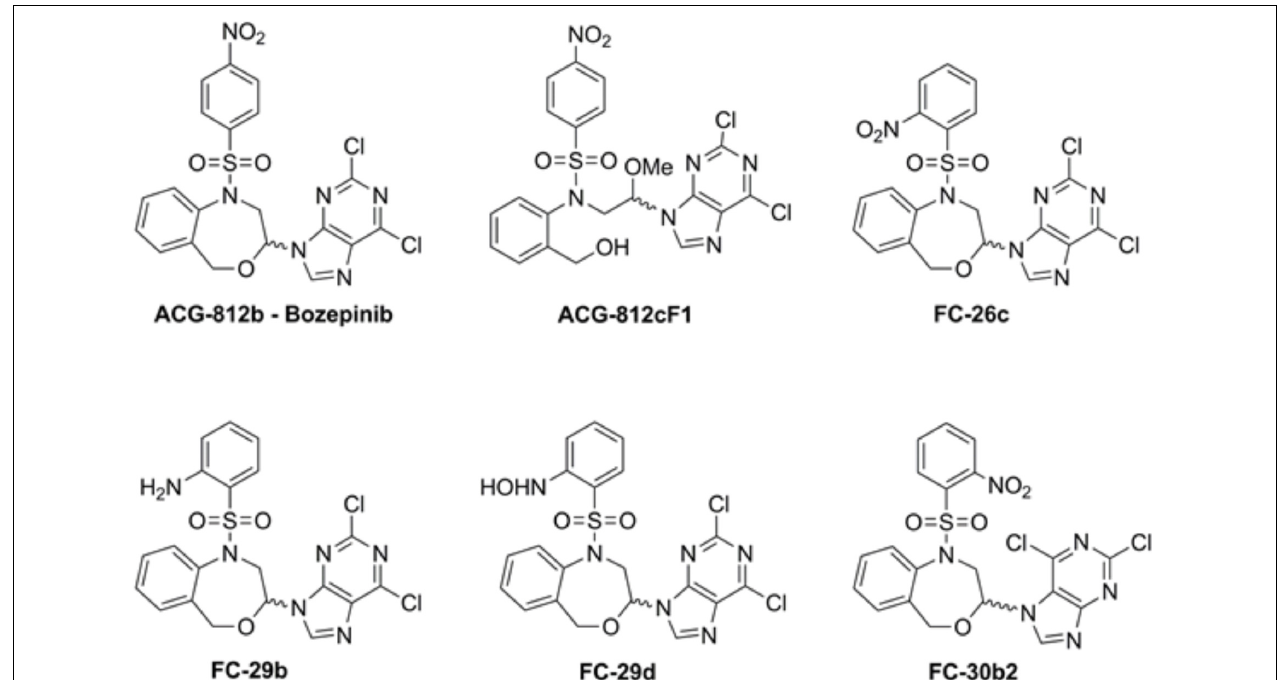
FIGURE 1 | Chemical structure of the